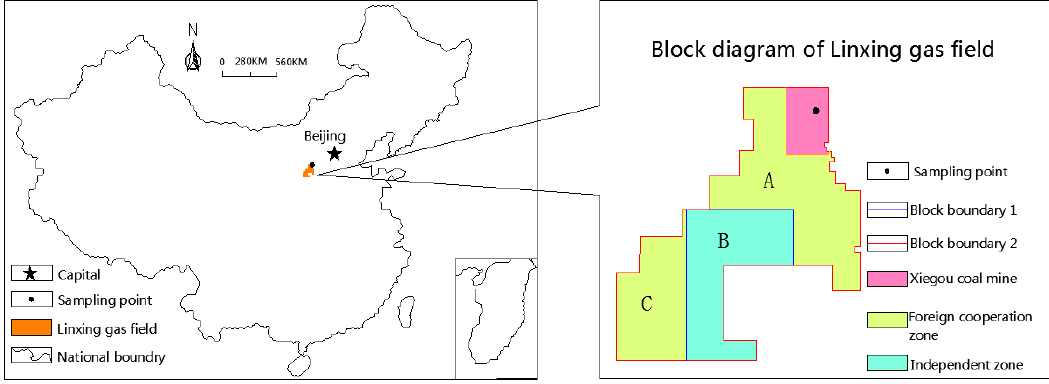
Figure 1 - Location of coal samples studied in this